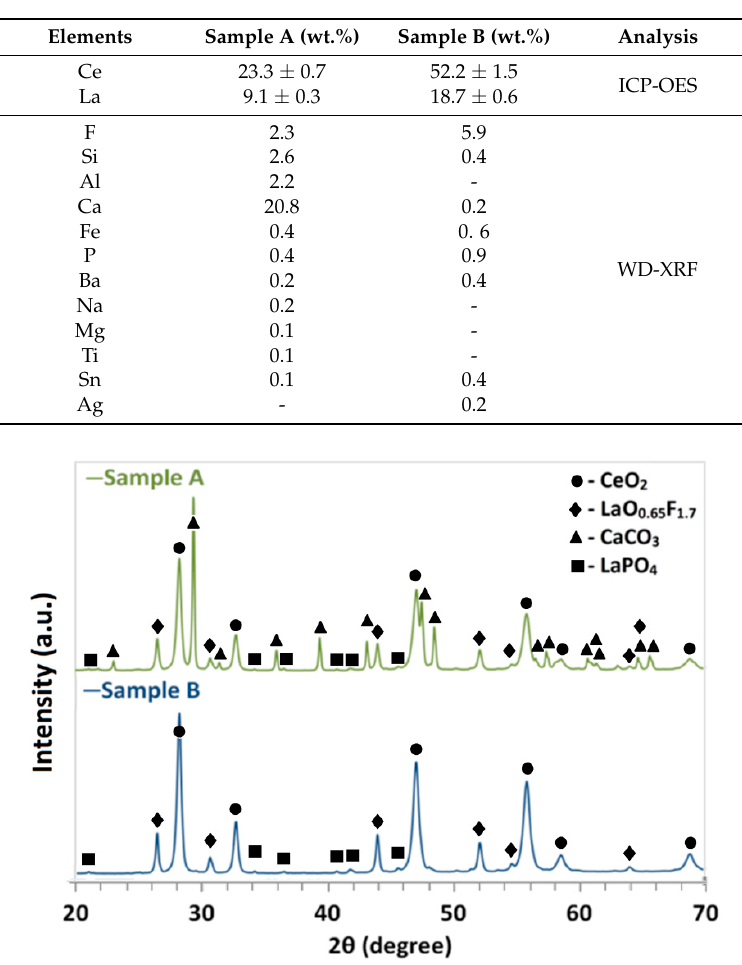
Table 1. Chemical analysis of polishing waste samples. Sample A (from plate glass polishing) contains a high amount of impurities whereas sample B (from mirror polishing) contains a small amount of impurities. Legend: ICP-OES, inductively coupled plasma optical emission spectrometry; WD-XRF: wavelength dispersive X-ray fluorescence spectroscopy.